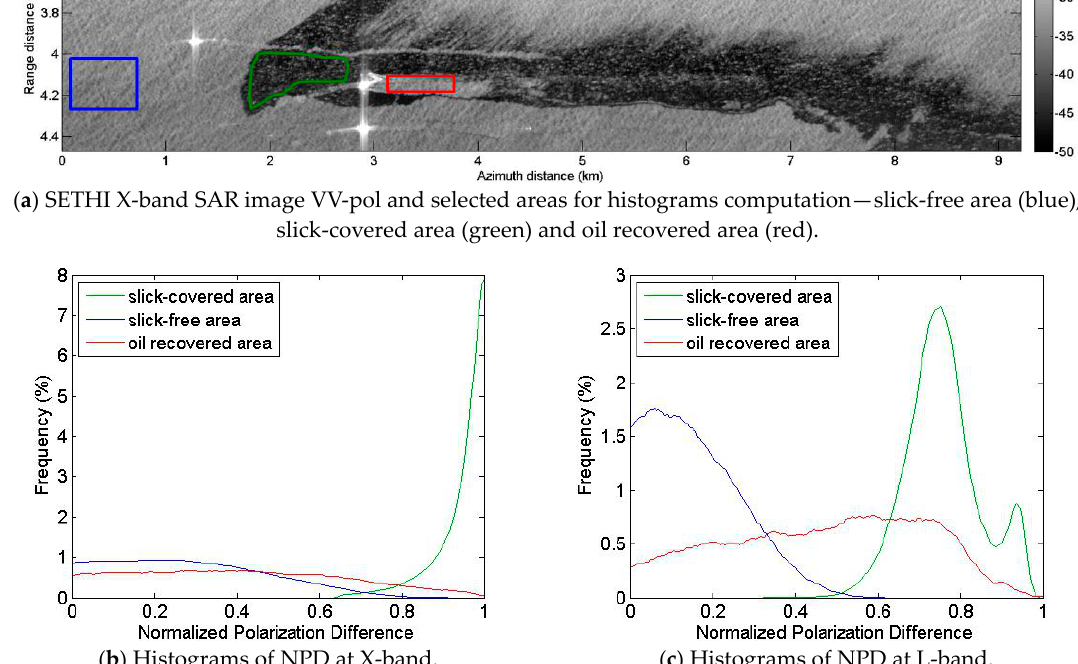
( b ) Histograms of NPD at X-band. ( c ) Histograms of NPD at L-band. Figure 17. SETHI NOFO’2015 on 9 June 2015 at 10:01 a.m. UTC: ( a ) X-band VV-pol SAR image and selected areas; and histograms of NPD parameter at: ( b ) X-band; and ( c ) L-band over slick-covered (green), slick-free (blue) and oil recovered areas (red).